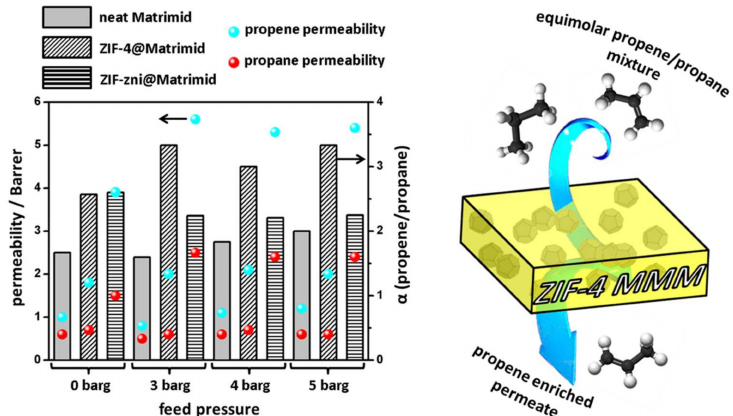
Figure 7. Mixed gas permeabilities for propene and propane as well as separation factors for two MMMs with porous materials (ZIF-4 and ZIF-zni) compared to a neat Matrimid membrane measured at 150 ◦ C ( left ). Schematic demonstration of a separation process with an MMM ( right